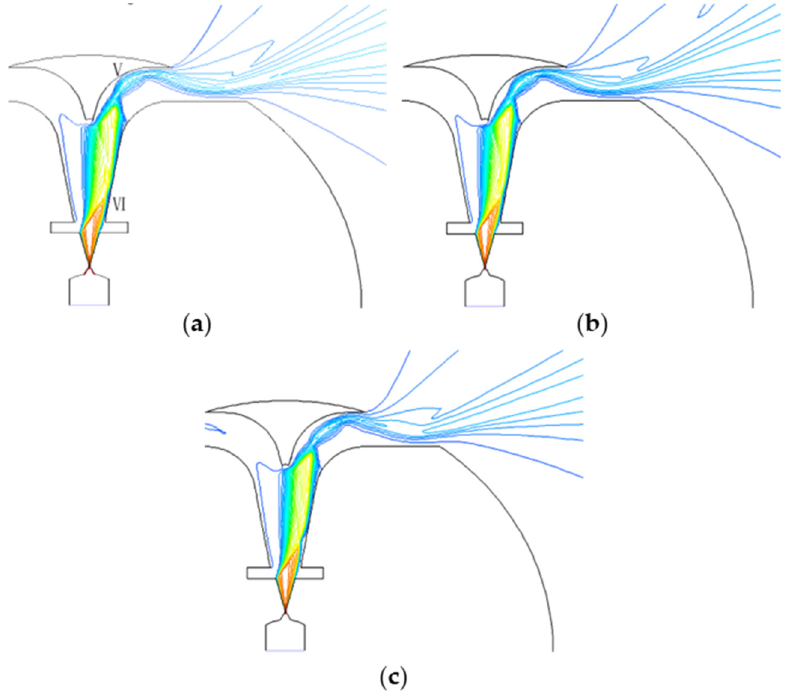
Figure 14. Total pressure contours at different rotational angular velocities: ( a ) 0 r/s, ( b ) 20 r/s, ( c ) 50 r/s.